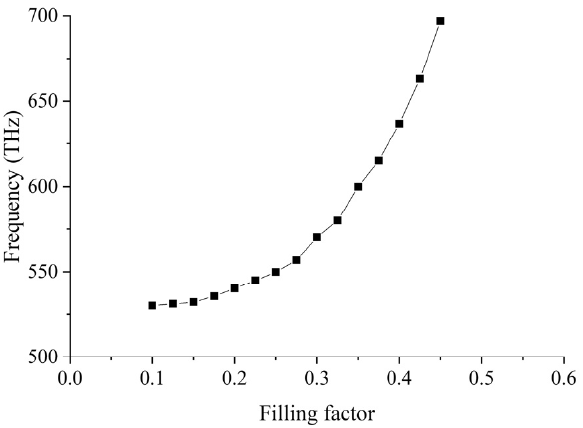
Figure 5. Correlation between changes in the position of SC points and HMM filling factor f .